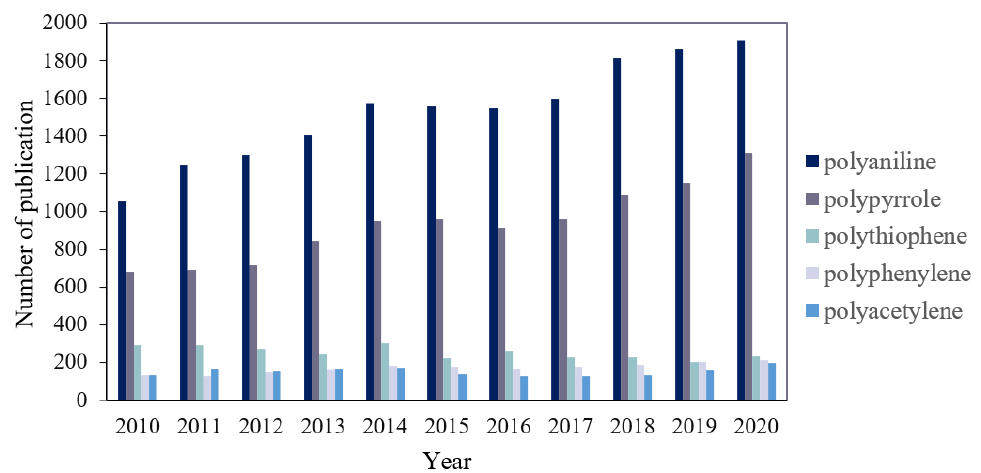
Figure 2. Evolution of the number of published papers between 2010 and 2020 with the keywords: “polyaniline”, “polypyr- role”, “polythiophene” “polyphenylene”, and “polyacetylene”, based on the Scopus database.